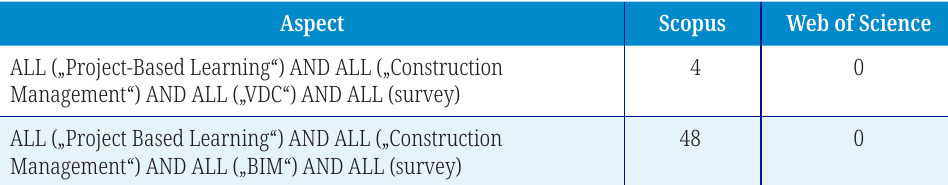
Table 4. Papers are found in Scopus and Web of Science databases